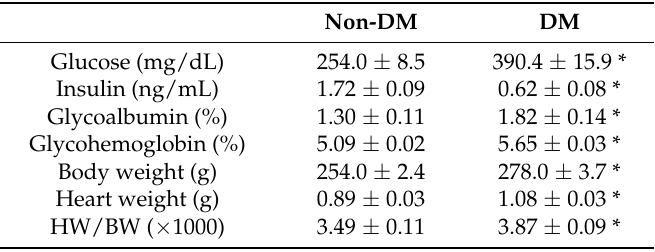
Table 1. Characteristics and laboratory data from non-diabetes mellitus (DM) and DM rats. In non-DM ( n = 5) and DM rats ( n = 5), heart weight (HW) and body weight (BW) were measured with blood samples before sacrifice. Data are shown as the means ± standard error of the mean (SEM). * p < 0.05 vs. non-DM by t